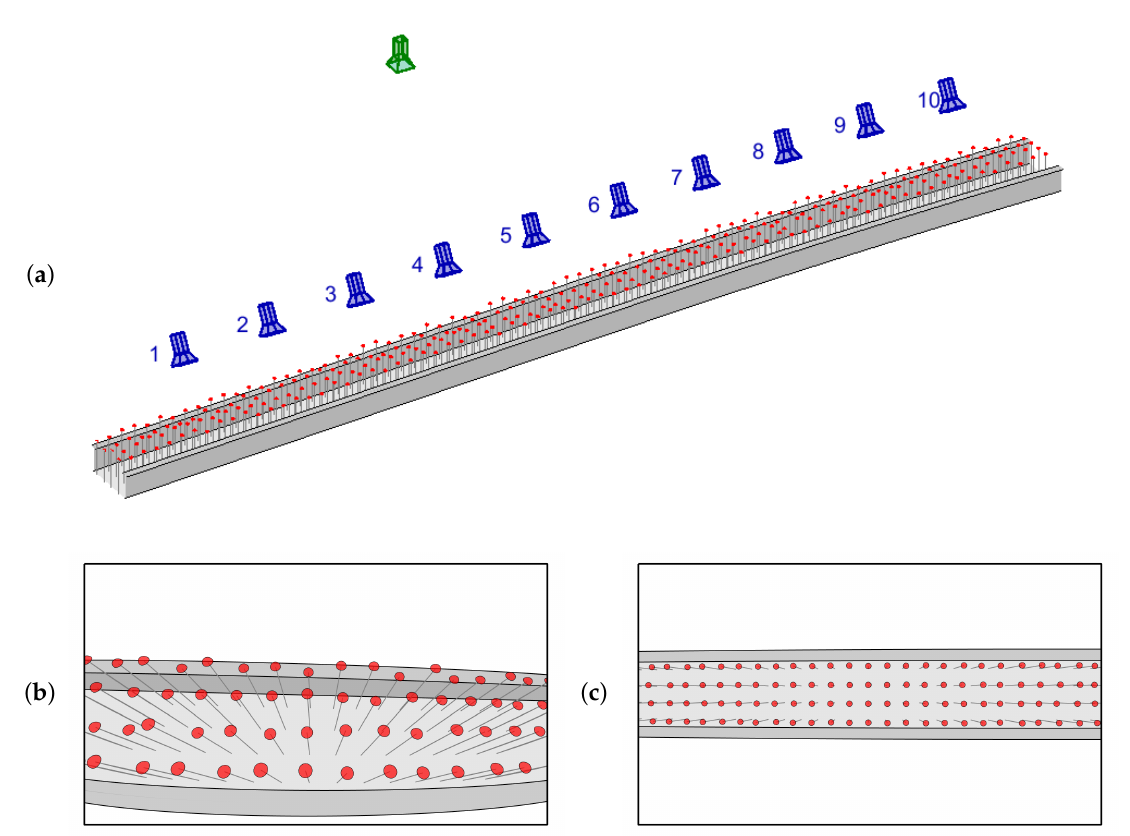
Figure 5. Results of the preliminary study of the location and orientation of the static (blue) and drone (green) camera setup: ( a ) half a bridge deck with simulated grid of pedestrians with a red hat and a uniformly distributed random height between 1.6 m and 2.0 m. FOV of ( b ) static camera 3 and ( c ) the drone camera.